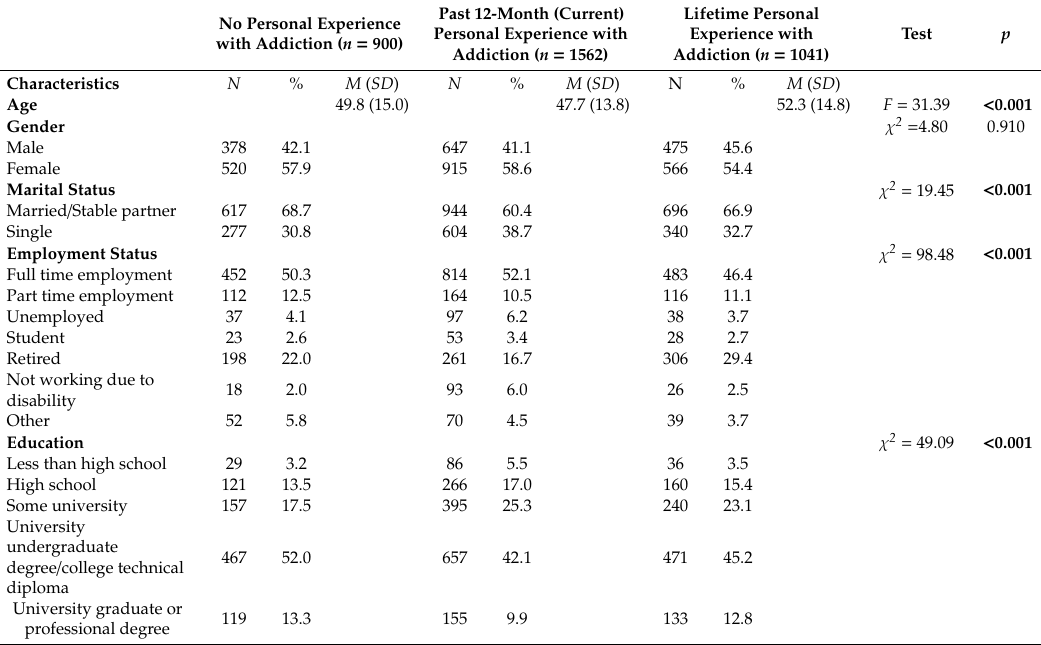
Table 2. Comparison of demographic characteristics between participants with and without personal experiences with the 10 addictive behaviors. Past 12-Month (Current) Lifetime Personal No Personal Experience Personal Experience with Experience with with Addiction ( n = 900) Addiction ( n = 1562) Addiction ( n = 1041)